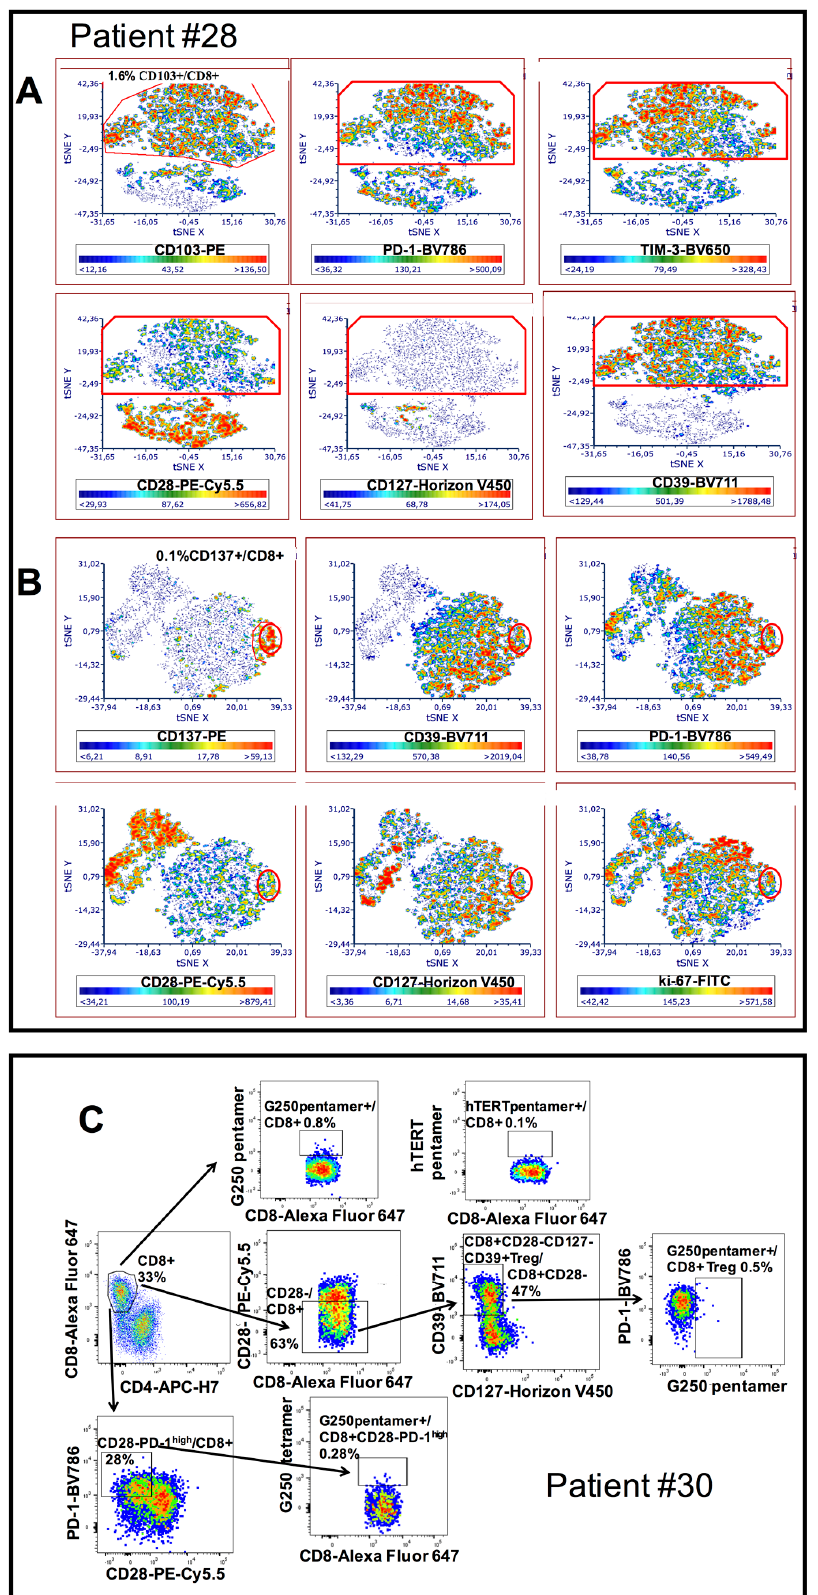
Figure 5. Further phenotypic characterization of tumor infiltrating CD8+CD28 − PD- identifies a map area where cell clusters, negative for CD28 and CD127 expression and highly positive for CD39,